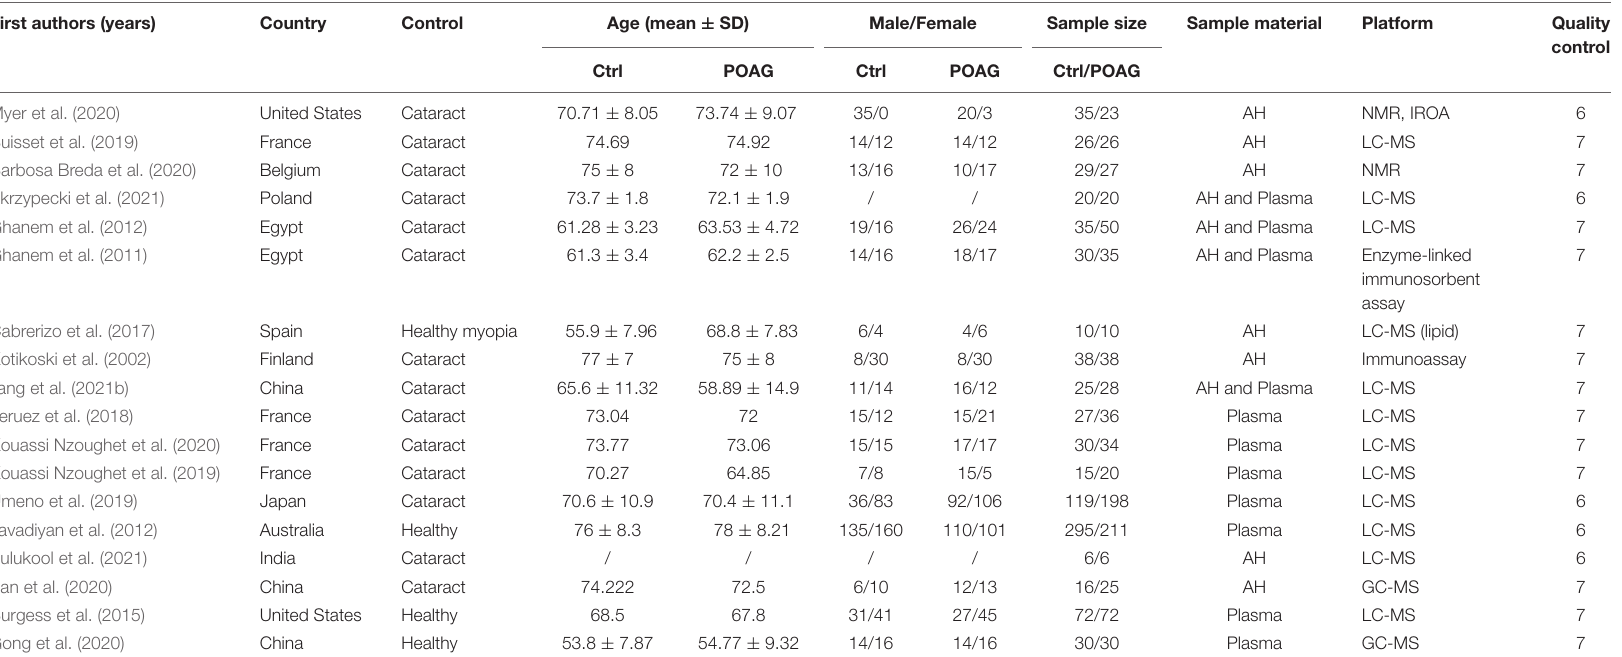
TABLE 1 | Basic information of the studies included in this review and